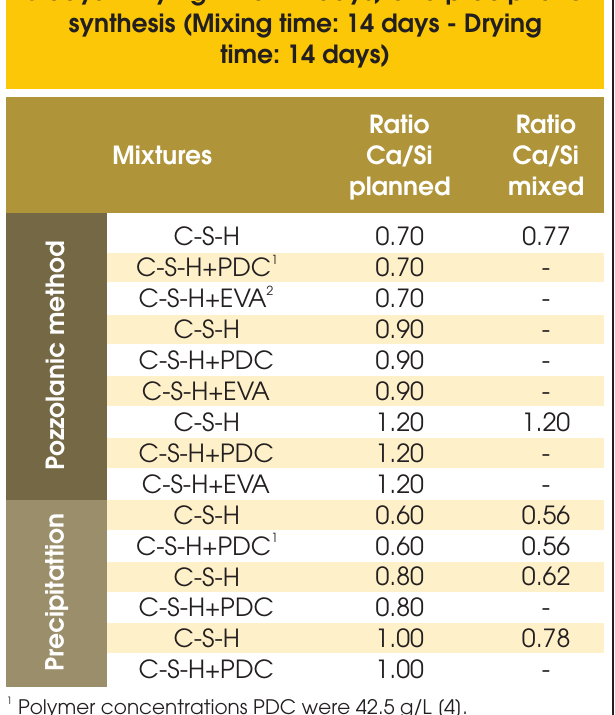
Table 1 – The Ca/Si molar ratio of C-S-H produced by pozzolanic synthesis (Mixing